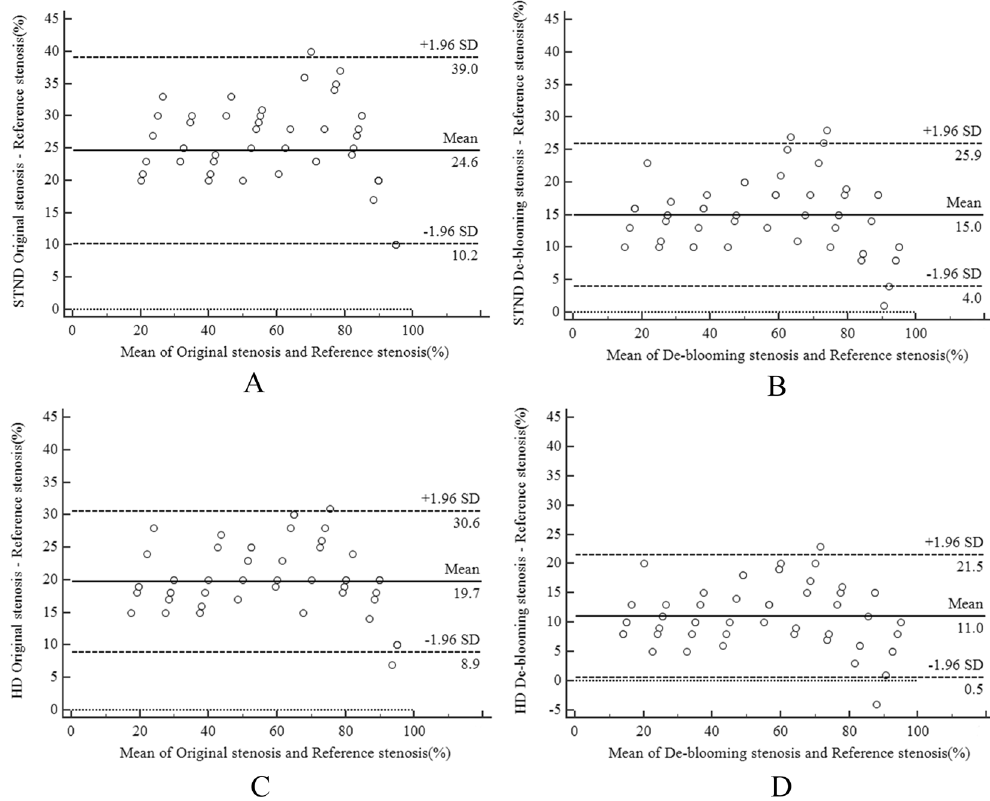
Figure 1. ( A – B ) Bland and Altman showing the correlation of Reference stenosis and Original stenosis without and with de-blooming algorithm using standard mode reconstruction (STND); ( C – D ) showing Reference stenosis and De-blooming stenosis without and with de-blooming algorithm using high definition mode reconstruction (HD STND). Only few cases are outside the boundary line (beyond two SD). SD = Standard